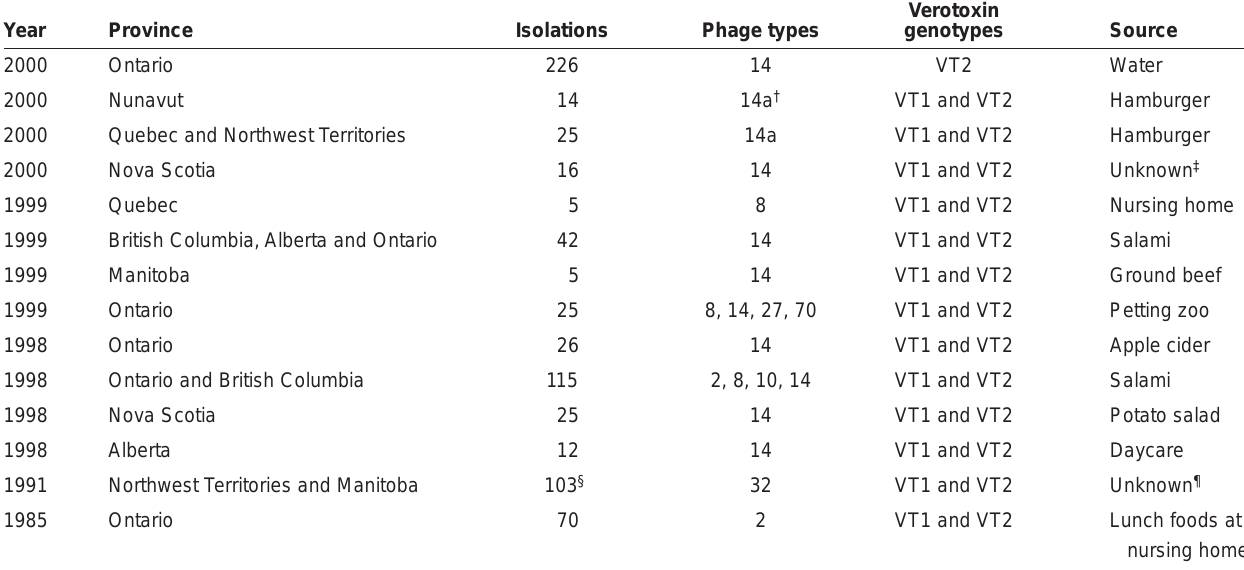
TABLE 2 Major outbreaks of Escherichia coli O157 in Canada since 1985*